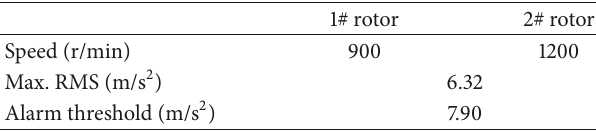
Table 1: Fixed alarm threshold for the test